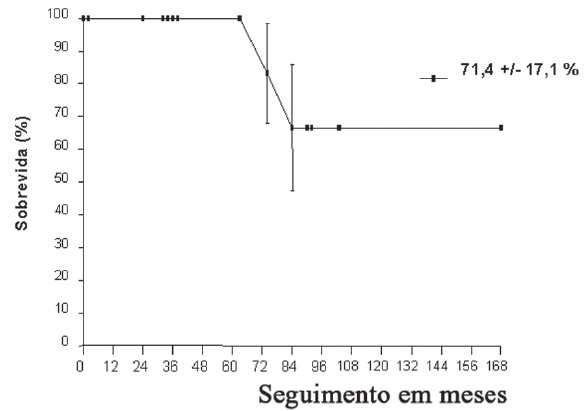
Fig. 4 - Sobrevida